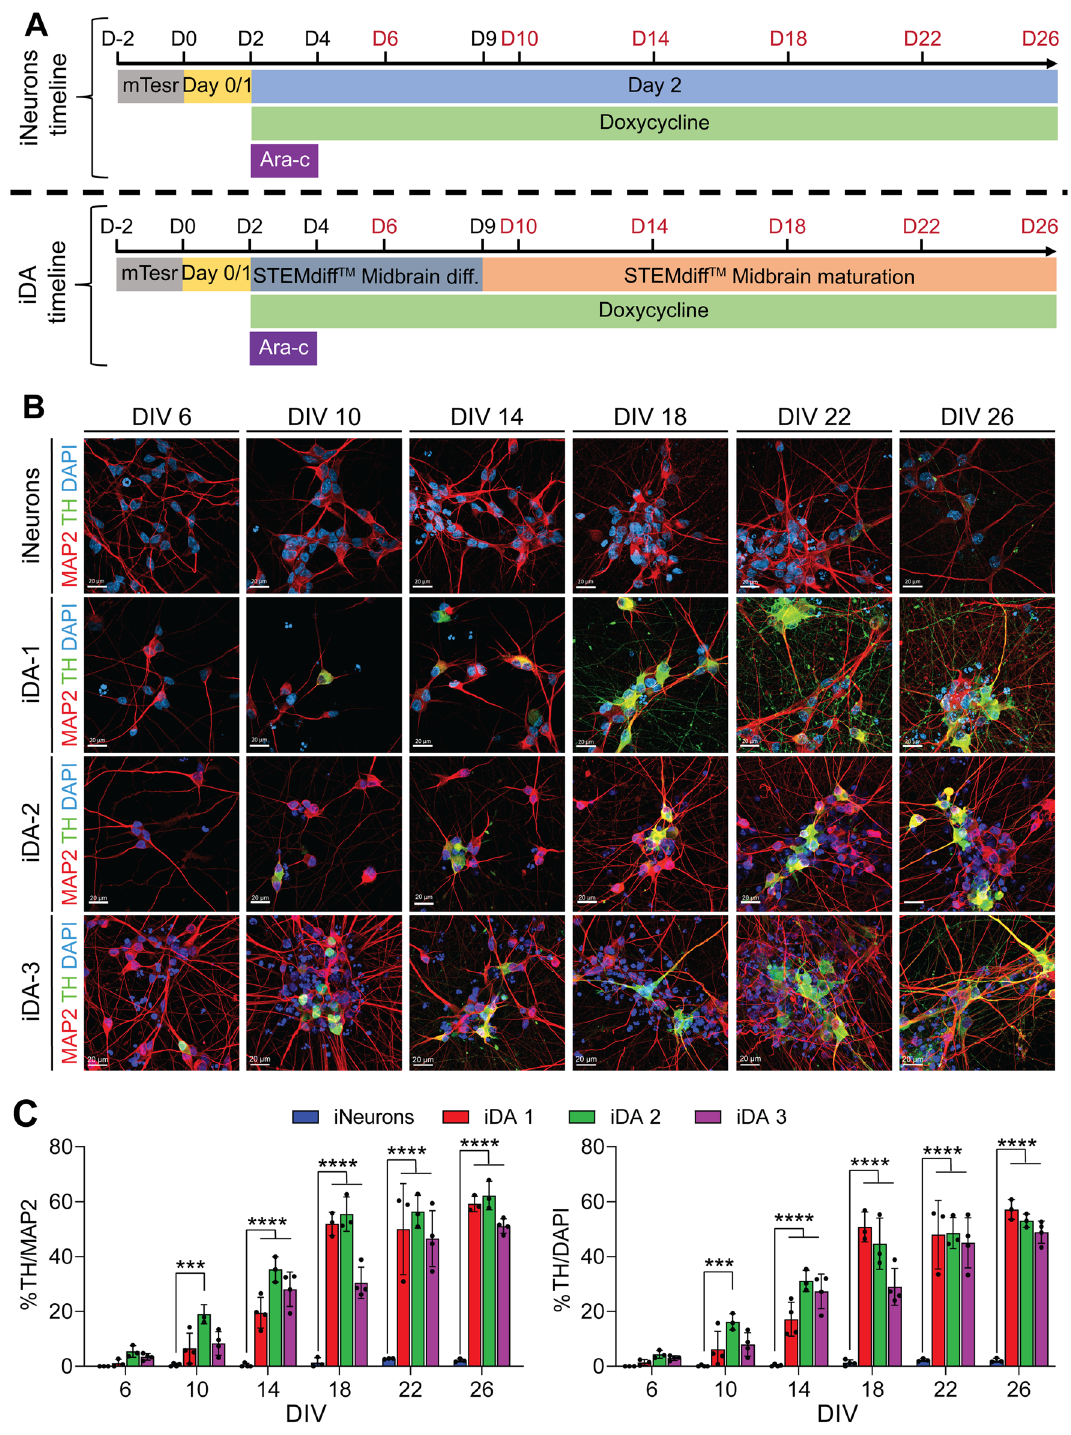
Figure 1. Combination of NGN2 overexpression and midbrain differentiation and maturation medias force the dopaminergic phenotype of the iPSC-derived iNeurons. ( A ) Schematic timeline of the use of different conditioning media to pattern, differentiate and mature hiPSCs to generate dopaminergic neurons (iDA). The iNeurons are patterned from hiPSCs from DIV 0 to DIV 2 using Day 0/1 media. Starting DIV 2, the cells are exposed to the doxycycline to induce NGN2 expression and neuronal differentiation and cultured in Day 2 media. From DIV 2 to DIV 4, cells were exposed to Ara-C to eliminate non-differentiated cells. To induce the dopaminergic phenotype, cells are exposed to the midbrain differentiating media supplemented with SHH from DIV 2 to DIV 9. Differentiated iDA neurons were then exposed to maturation media allowing them to reach a late maturation stage at DIV 26. ( B ) Representative confocal illustrations of ICCs against TH (green) and MAP2 (red) for iNeurons or iDA neurons from 3 iPSC lines (iDA-1, iDA-2 and iDA-3) at different timepoints. Scale bars: 20 µm. ( C ) Quantitative analysis of the percentage of TH + neurons for iNeurons and iDA-1, iDA-2 and iDA-3 neurons at different timepoints. Data represent the average percentage of TH + neurons normalized against MAP2 + positive neurons or total number of DAPI nuclei (n = 4). Statistical differences were assessed performing a 2-way ANOVA Šídák’s multiple comparisons test comparing iDA neurons to iNeurons at each time point. ***p < 0.001; ****p <